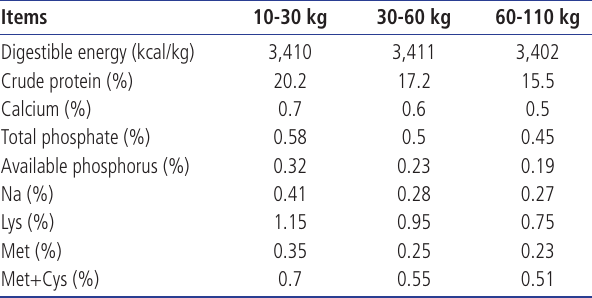
Table 2. Nutrition levels of diets for pigs at the three stages